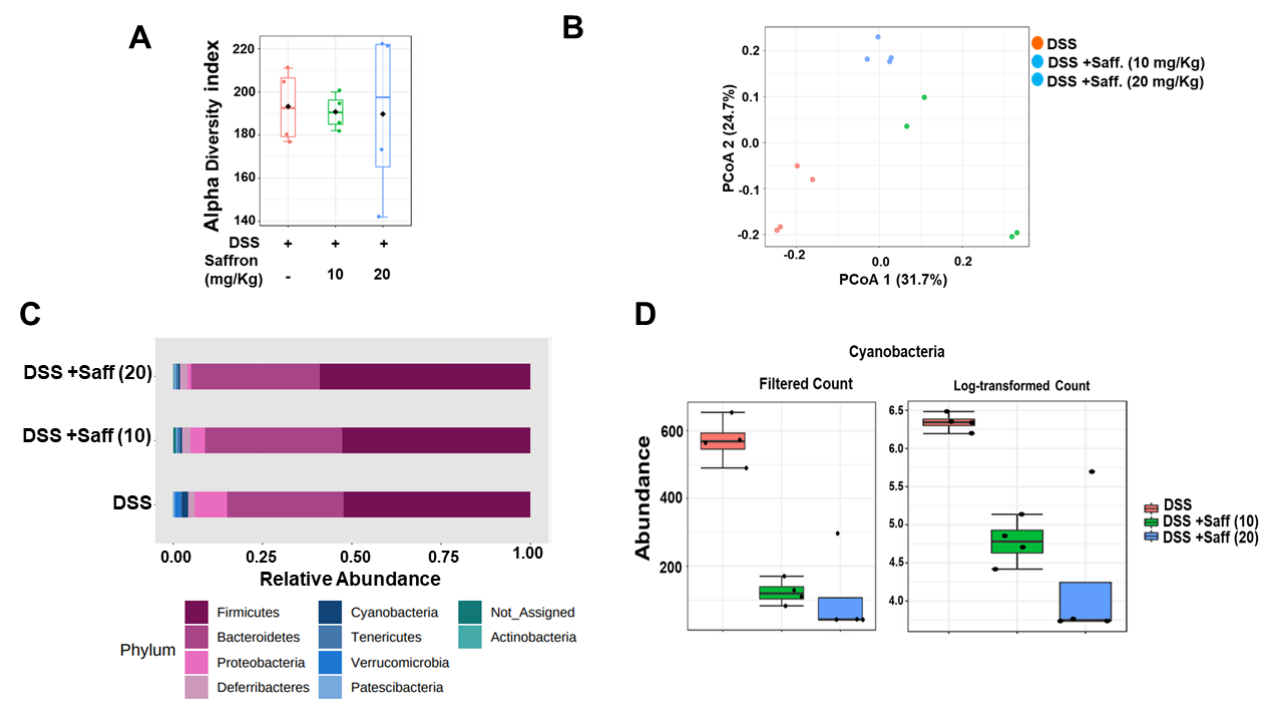
Figure 3. Microbial composition analysis in the cecal samples of saffron pre-treated and untreated mice challenged with DSS. The cecal content of mice were subjected to 16S rRNA partial sequencing profiling analysis and the figure represents ( A ) the alpha diversity of the three group of mice using the Chao1 index. ( B ) PCoA of the Bray–Curtis dissimilarity, showing distinct microbiota in each group of mice. ( C ) Taxonomic summaries at the phylum level. ( D ) Abundance of Cyanobacteria in the saffron-treated and untreated groups ( n = 4/group).